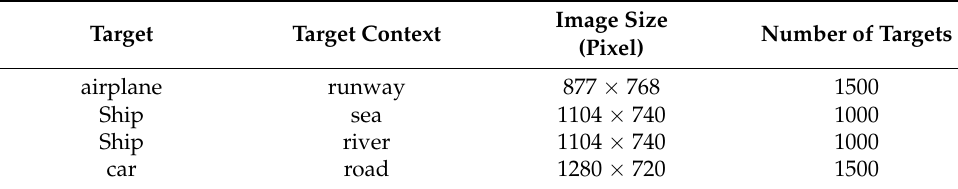
Table 2. The detailed information of the collected